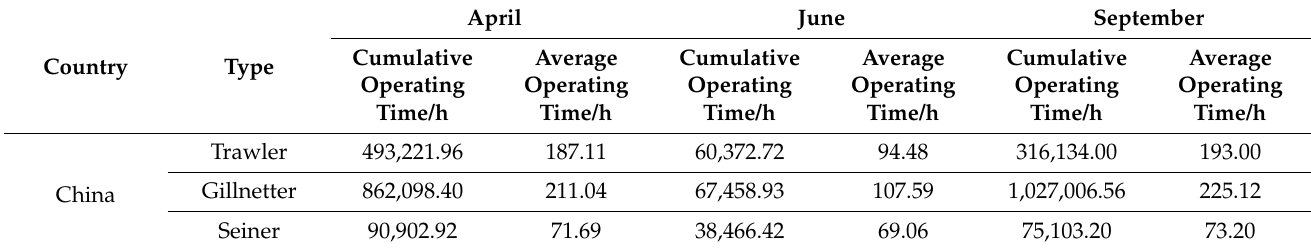
Table 10. Cumulative and average fishing duration of trawlers, gillnetters and seiners in April, June and September.